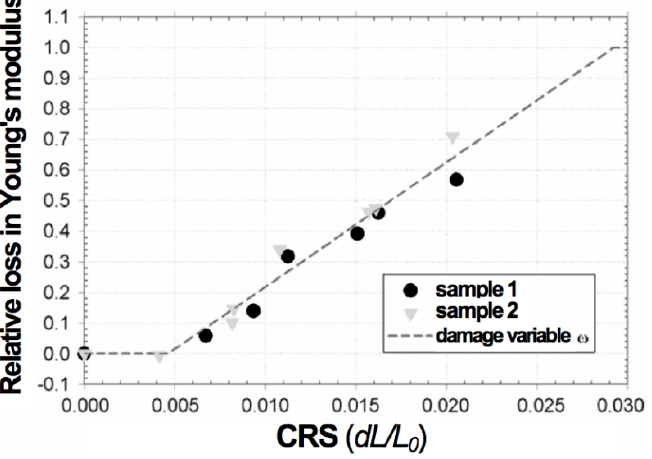
Figure 9. Mechanical degradation in terms of relative loss of elastic modulus of NiO-YSZ composite in its oxidized state during RedOx cycle as a function of the oxidation strain (CRS: cumulative redox strain). The measurement is reproducible ( i.e. , samples 1 and 2)